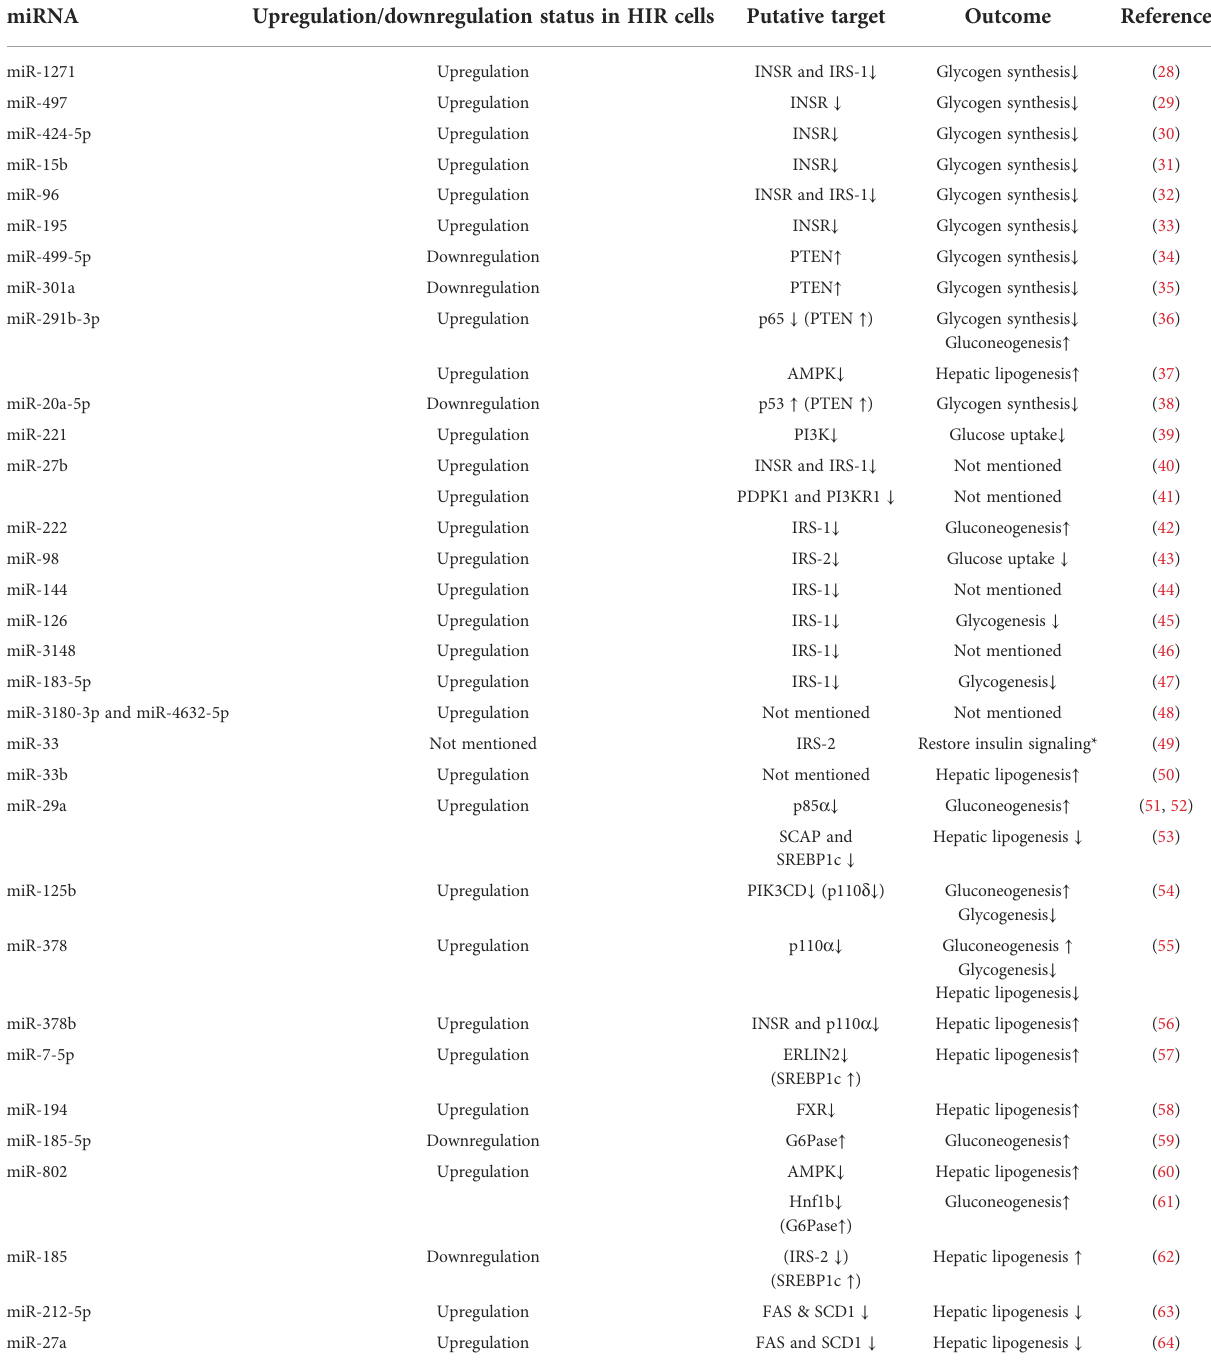
TABLE 1 Insulin resistance-associated hepatic miRNAs with their expression changes and functions during